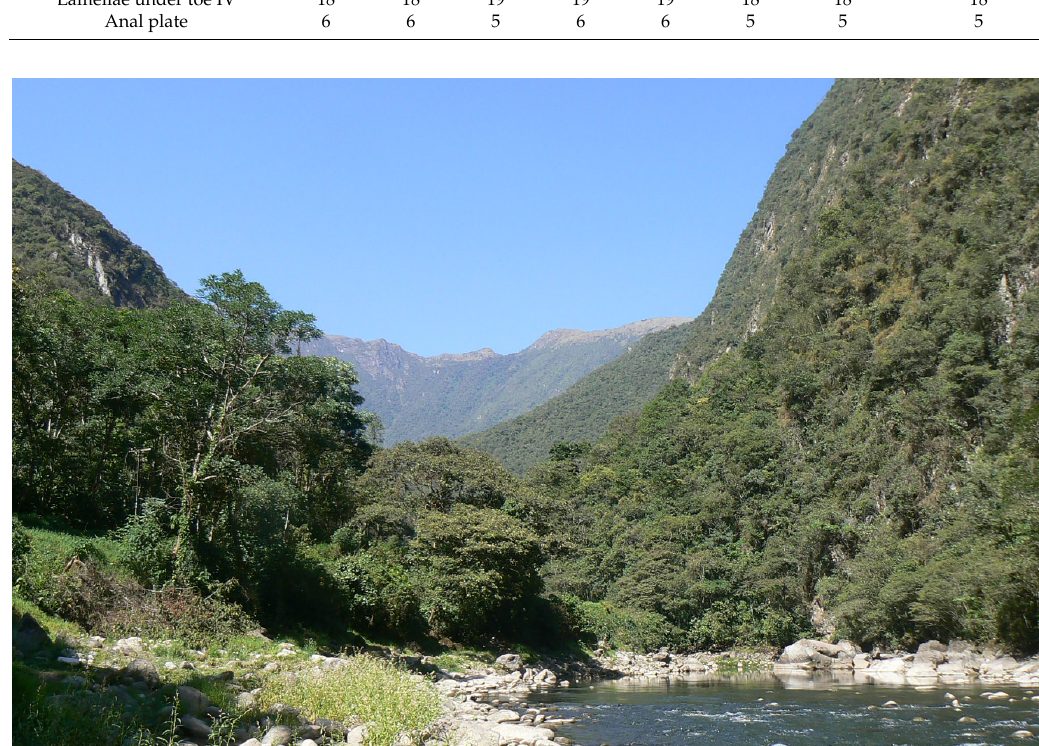
Figure 5. Habitat of Cercosaura anomala in the montane forest of the Historical Sanctuary of Machupicchu, Department of Cusco.